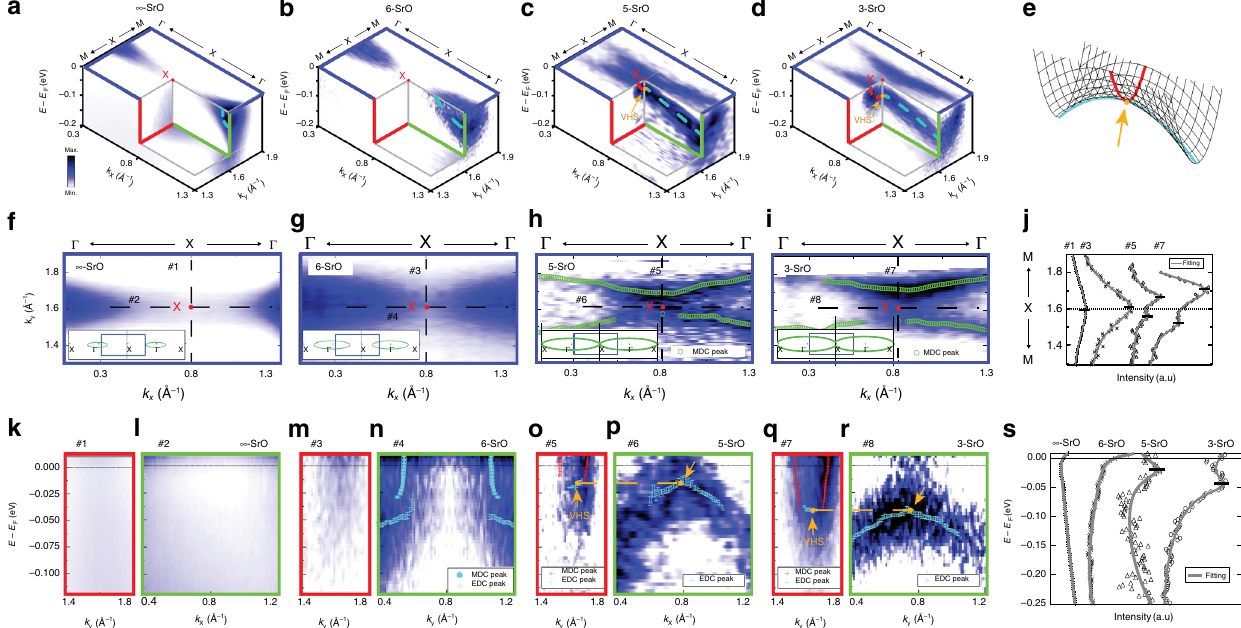
Fig. 3 Topology change in Fermi surface and emergence of Van Hove singularity. 3D ARPES spectra around the X point for 1 -SrO ( a ), 6-SrO ( b ), 5-SrO ( c ), and 3-SrO ( d ), including the symmetrized Fermi surfaces relative to the d yz states (blue squares) and the energy and momentum cuts along M-X-M (red squares) and Γ -X- Γ (green squares). The red and light-blue dashed lines are guides to eyes, displaying the dispersion along M-X-M and Γ -X- Γ , respectively. The yellow dot and arrow in c , d indicate the location of the Van Hove singularity (VHS) at X points. e A schematic of a general saddle-point singularity. The yellow dot and arrow indicate the saddle-point where the dispersion has the local minimum in one direction (red) and local maximum in another direction (light-blue). The Fermi surface around X point for 1 -SrO ( f ), 6-SrO ( g ), 5-SrO ( h ), and 3-SrO ( i ), respectively. The blue squares in the insets show the locations of the Fermi surfaces. Peak positions, obtained by fi tting with Lorentzian curves along k y -direction, are shown in h and i with green dots superposed. The error bar of peak positions is smaller than the size of dots. j MDCs at E F along M-X-M (cuts #1, #3, #5, and #7 in f – i ,) for 1 -SrO (#1), 6-SrO (#3), 5-SrO (#5), and 3-SrO (#7) with fi ttings (gray lines) from left to right. For a direct comparison, all MDCs here are normalized based on the intensities at k y ¼ 1 : 3. k – r The energy and momentum cuts for cuts #1 – 8 as shown in f – i . All spectra shown here are divided by the energy resolution convolved Fermi-Dirac function (FD) at the measured temperature. The peak positions in the MDC and EDC are denoted by red (light-blue fi lled circles in n ) and light-blue cross dots, respectively, in n – r . The yellow dashed line and arrows in o – r are guides to the eyes to indicate the location of the VHS at X points. The error bars in n – r represent the uncertainties of peak positions from Lorentzian fi ts. s FD divided EDCs around X points for 1 -SrO, 6- SrO, 5-SrO, and 3-SrO with fi ttings (gray lines) from left to right. All EDCs are normalized for Fig. 4d. The change of Fermi surface topology, accompanied by